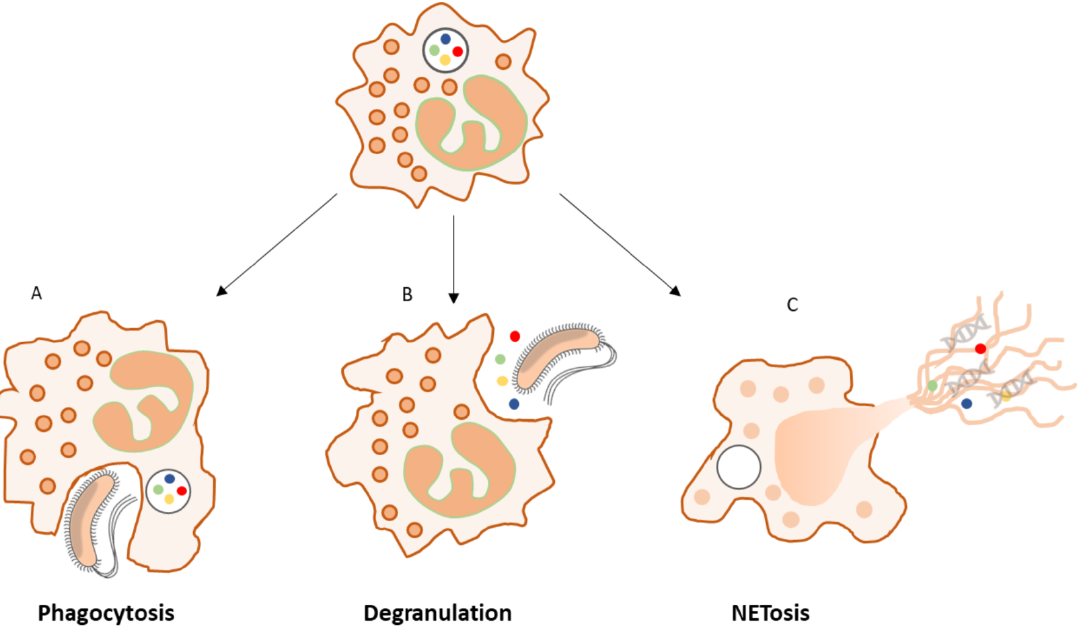
Figure 1. Intra- and extracellular neutrophil killing mechanisms. During phagocytosis ( A ), microor- ganisms are encapsulated within phagosomes. Pathogens are then killed by reactive oxygen species (ROS) or antimicrobial proteins. These antimicrobial proteins may be released from neutrophil gran- ules into the extracellular milieu to kill pathogens by degranulation ( B ). Highly activated neutrophils can eliminate extracellular microorganisms by releasing neutrophil extracellular traps (NETs) ( C ). NETs are composed of core DNA to which histones, proteins, and enzymes (e.g., myeloperoxidase (MPO) and human neutrophil elastase (HNE)) are attached. Such structures immobilize pathogens near granules and facilitate phagocytosis of trapped microorganisms by other cells. NETosis and its role in biofilm-related infection are discussed in Section